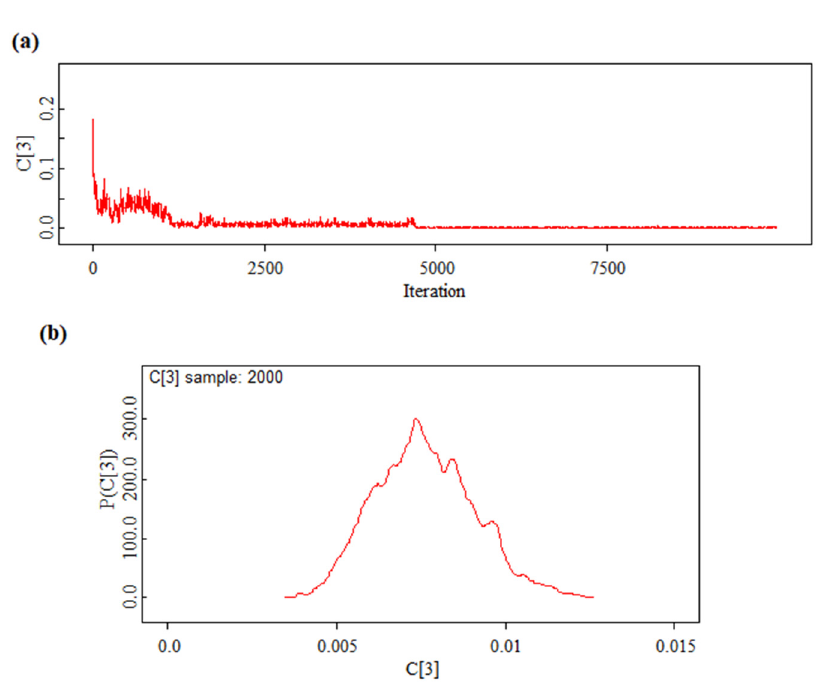
Figure 5. ( a ) MCMC simulation history of the C parameter to achieve convergence. ( b ) The posterior distribution of the parameter.